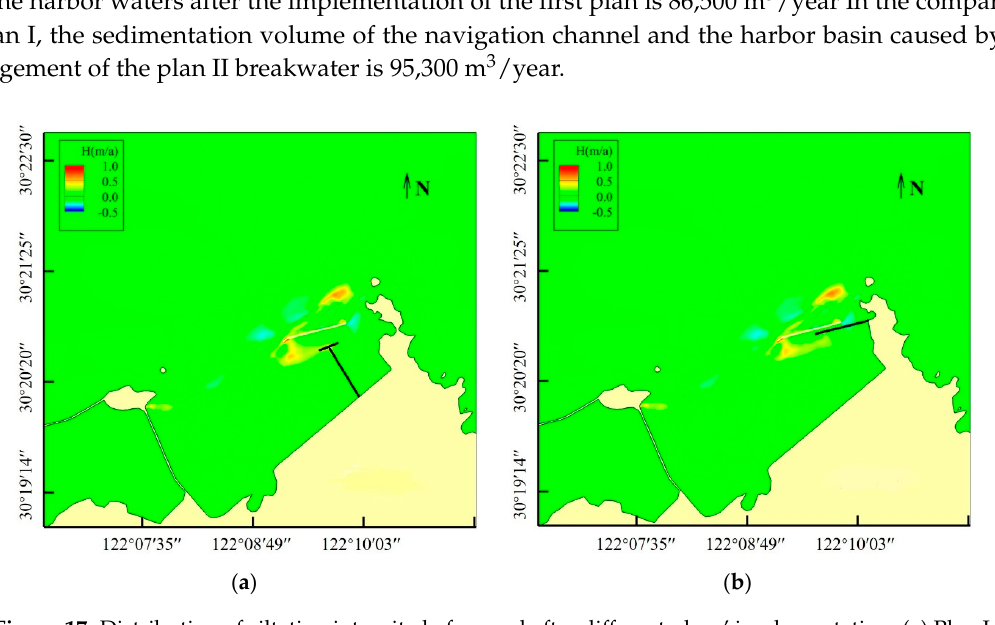
and harbor basins after each plan implementation.